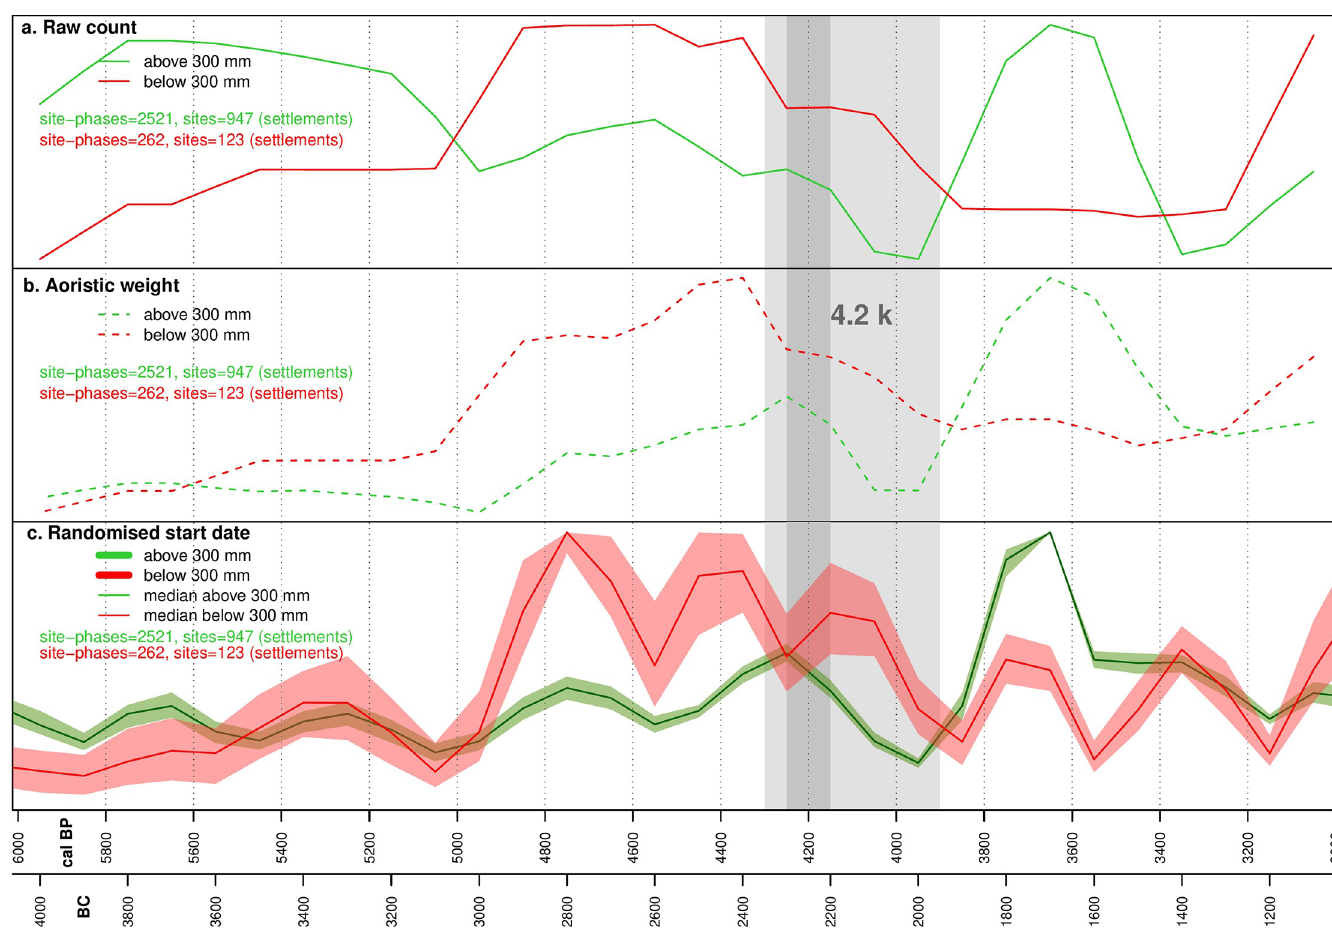
Fig 4. Rural settlement dataset trends by rainfall. a: Raw site counts. b: Aoristic weight. c: Randomized start dates.